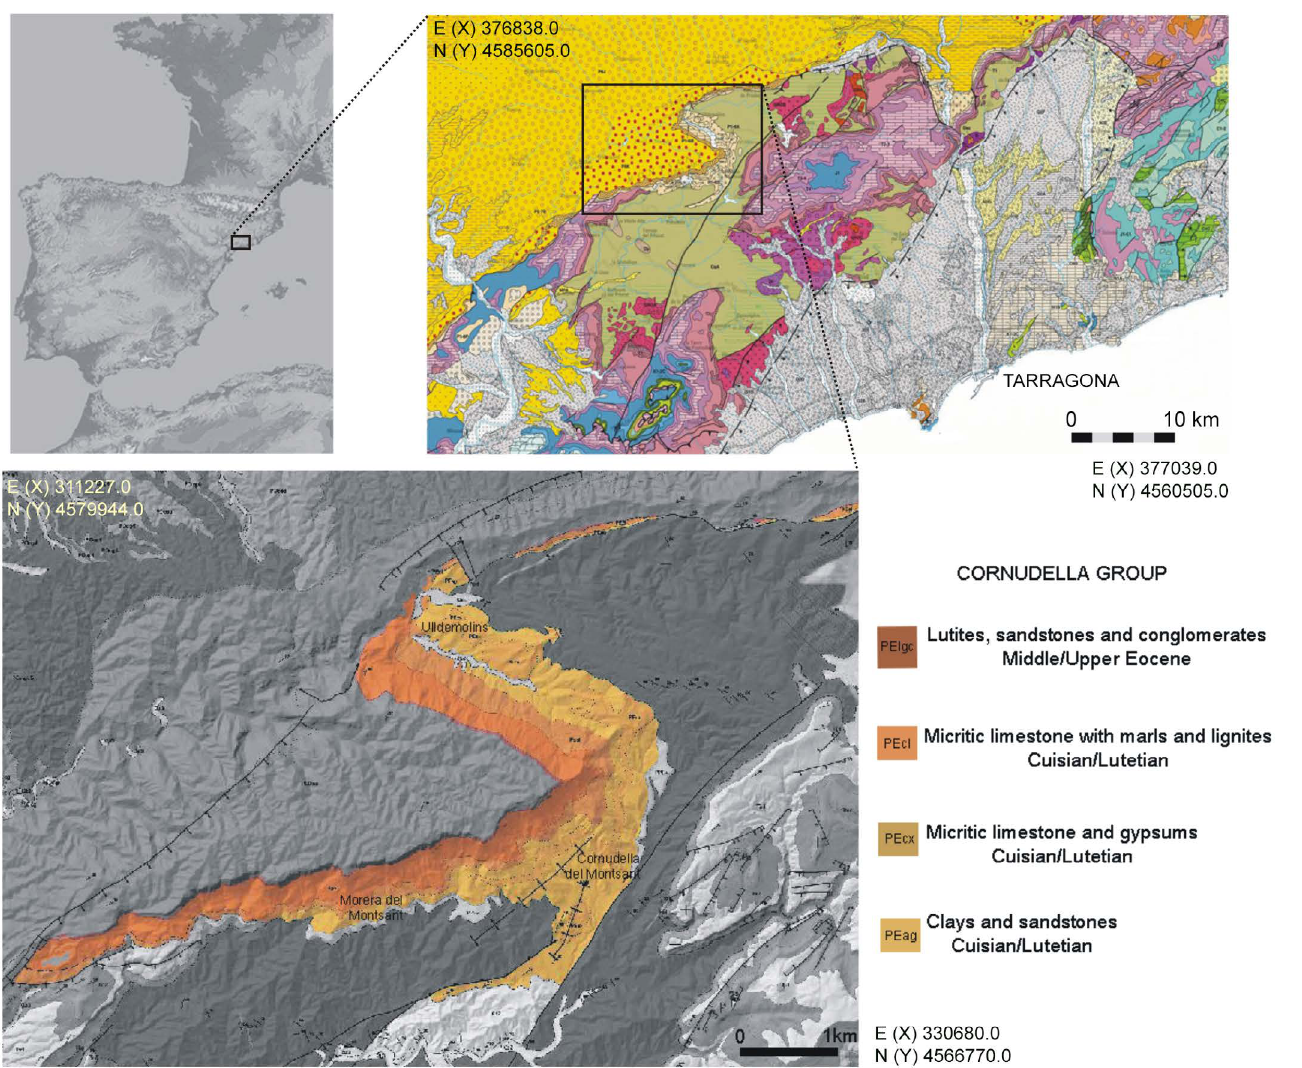
Figure 1. Detail of the geologic map of the Monstant Massif location and the Cenozoic coverage associated with the Cornudella Group (Geological maps, 1:50,000 - UTM 31N (ETRS 89), modified from ICGC